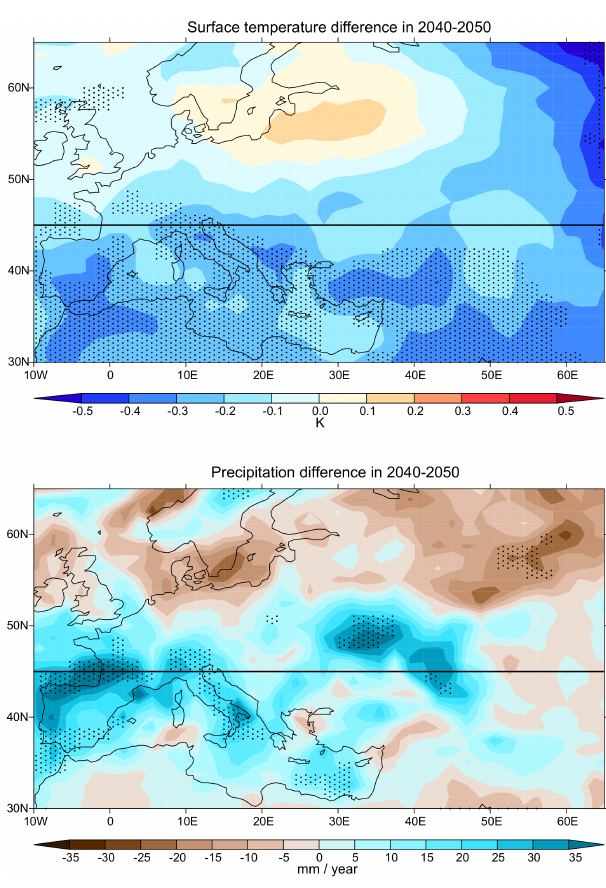
Figure 16. Annual average differences in (top) surface tempera- ture and (bottom) precipitation over Europe between the transient simulations based on the mitigation (MIT) and the current legisla- tion (CLE) scenario, averaged over the last 10 years of the simula- tions (2041–2050). Stippling shows where all four models agree on the sign of the response. The thick horizontal line distinguishes the southern and northern Europe boxes. In the top panel, negative val- ues mean that temperature in the MIT scenario is lower than in the CLE scenario; in the bottom panel, positive values mean that there is more precipitation in the MIT than in the CLE scenario.